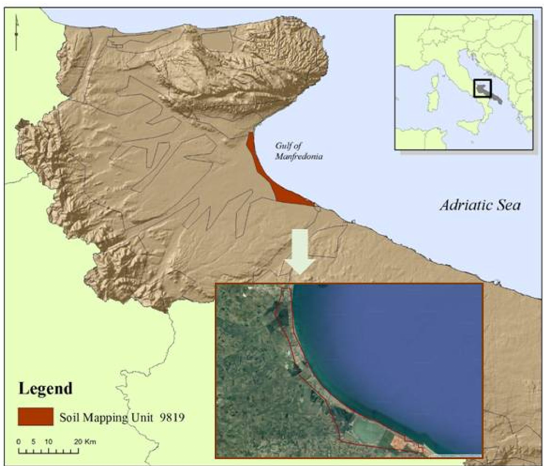
Figure 1. Reference area, identified by the soil mapping unit N ◦ 9819 of the Harmonized World Soil Database